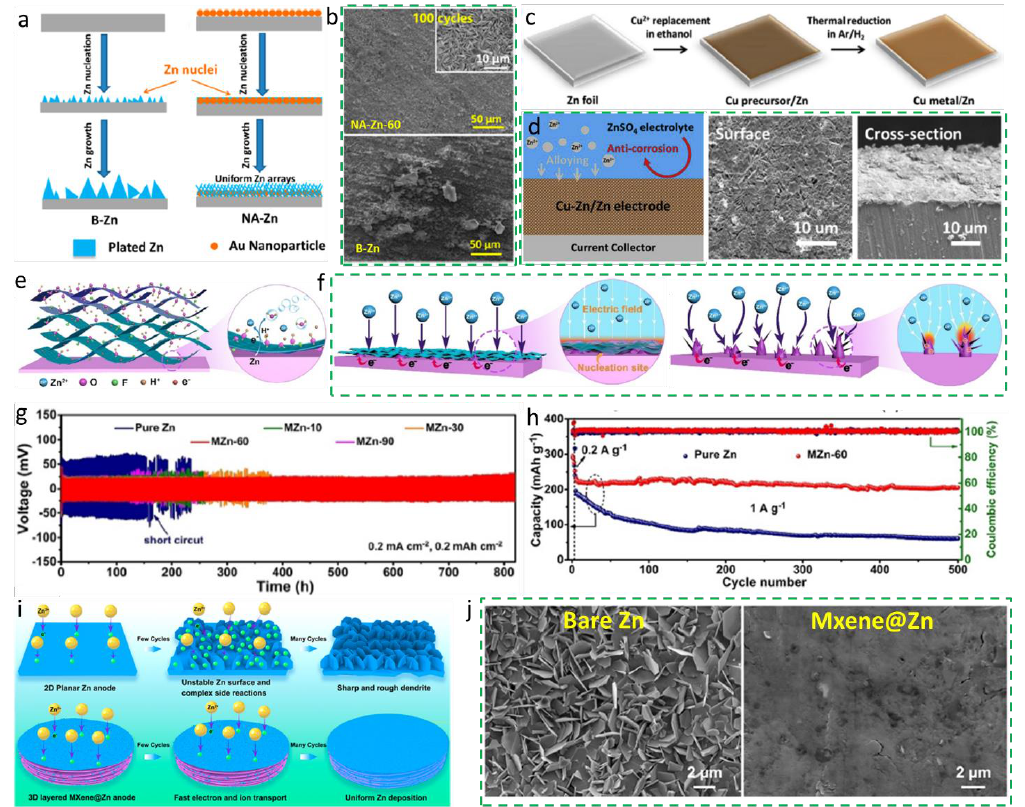
Figure 7. ( a ) Schematic illustration of the Zn stripping/plating process on B-Zn and NA-Zn anode and ( b ) SEM images of B-Zn and NA-Zn after 100 cycles at 0.25 mA cm −2 – 0.05 mAh cm −2 of symmet- ric Zn cells (Reproduced with permission. [90] Copyright 2019, American Chemical Society). ( c ) Di- agram illustrating the fabrication process of the Cu/Zn electrode and ( d ) Schematic illustration of the function, and the top-view and cross-section SEM images of Cu/Zn electrode (Reproduced with permission. [91] Copyright 2020, Elsevier). ( e ) Schematic illustration of synchronous reduction and assembly of MXene layers on Zn foils, ( f ) illustration of Zn plating behavior of MXene-coated Zn and pure Zn, ( g ) long-term cycling performance at 0.2 mA cm − 2 – 0.2 mAh cm − 2 , and ( h ) long-term cycling performance at 1 A g − 1 after 500 cycles. (Reproduced with permission. [98] Copyright 2021, John Wiley & Son). ( i ) The evolution of the morphology of the bare Zn and Ti 3 C 2 T x MXene@Zn anodes during stripping and plating and ( j ) SEM image bare Zn and Ti 3 C 2 T x MXene@Zn anode after being cycled (Reproduced with permission. [100] Copyright 2019, American Chemical Society).